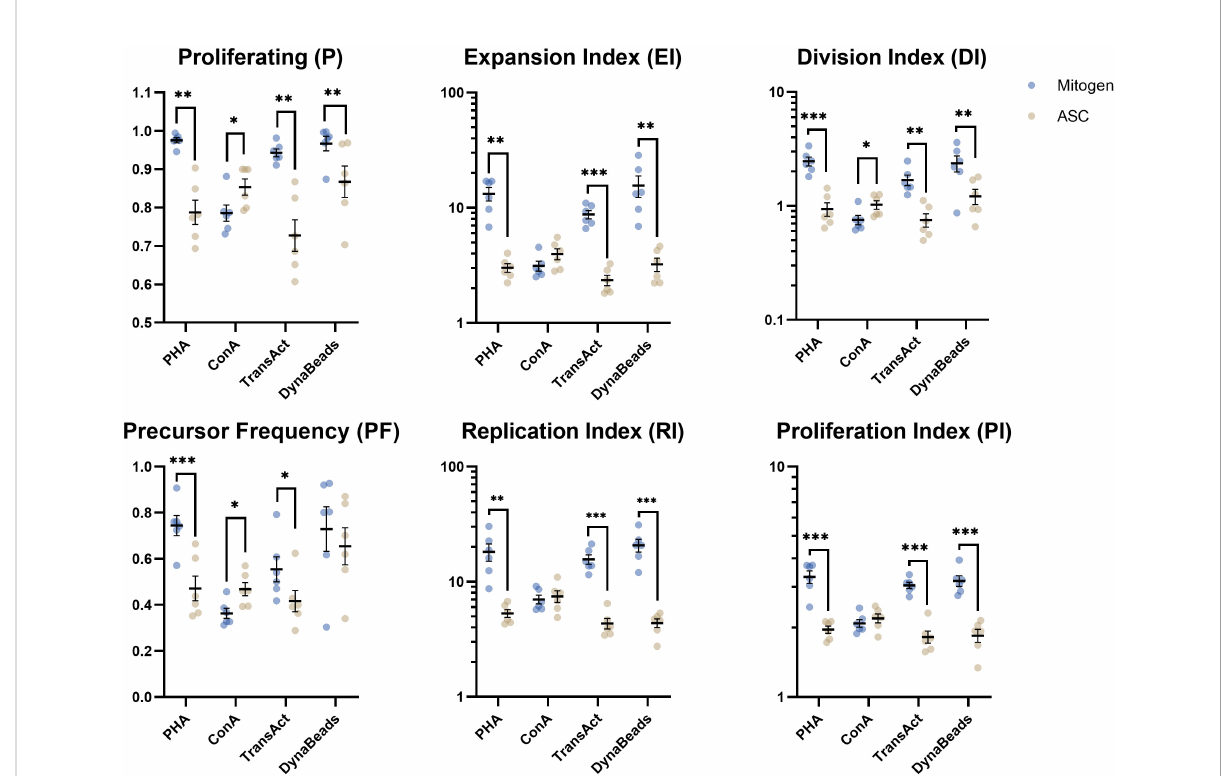
FIGURE 3 Analysis of 6 proliferative metrics by model fi tting of T cells. PBMC were stimulated with four different mitogens at optimum concentration in absence or presence of ASC (blue and yellow dots, respectively) to demonstrate the inhibitory effect on lymphocyte proliferation. Paired t test. Signi fi cance levels of *) p < 0.05; **) p < 0.01; ***) p < 0.001. n=6. PBMC, Peripheral Blood Mononuclear Cells; PHA, Phytohemagglutinin; ConA, Concanavalin A; ASC, Adipose tissue-derived Stromal